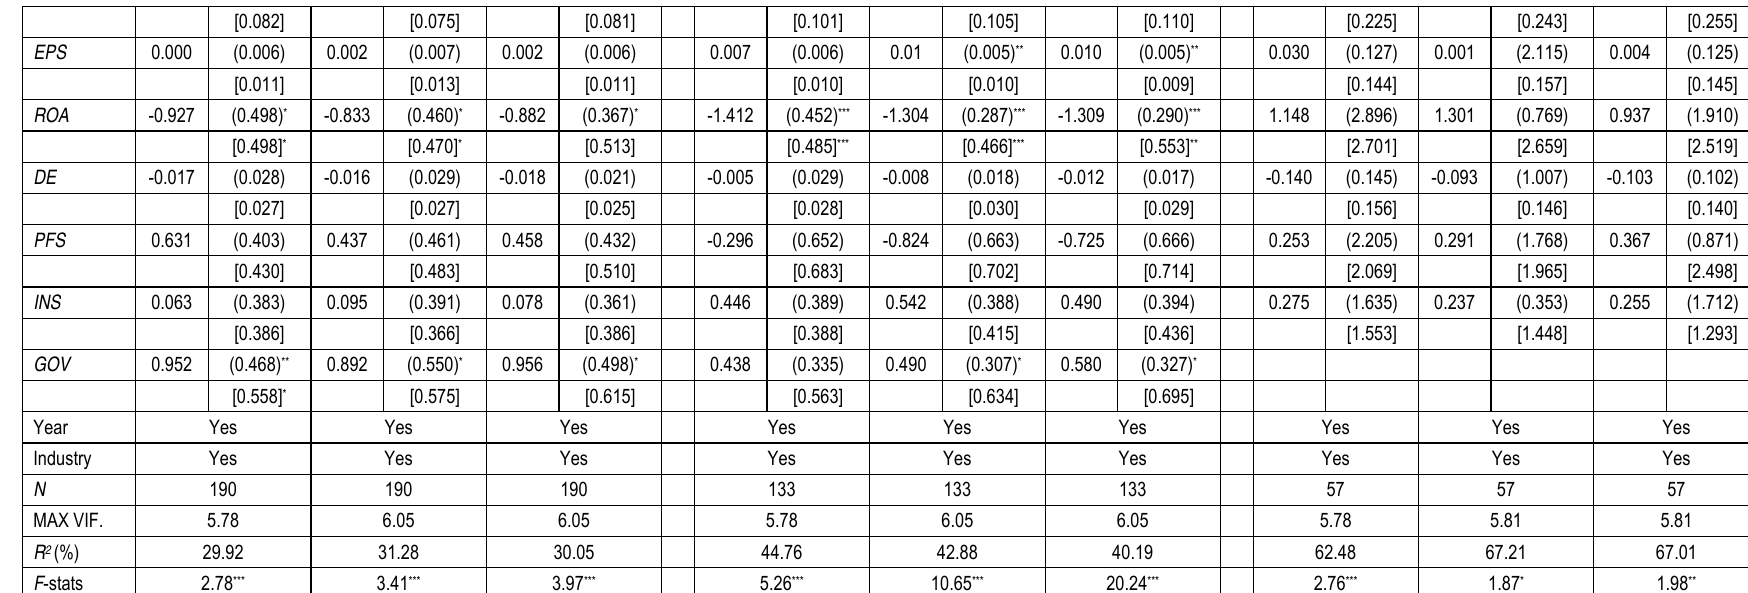
Table 8. OLS estimates-robust and bootstrap standard errors